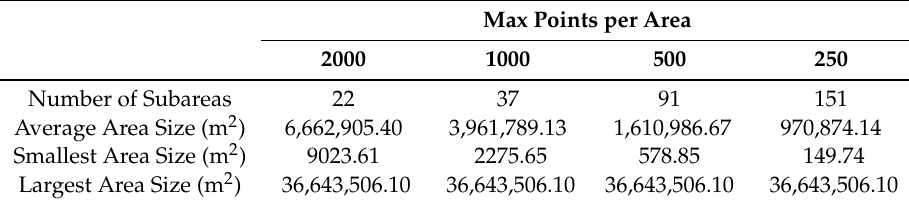
Table 14. Maximum points per area and area size.